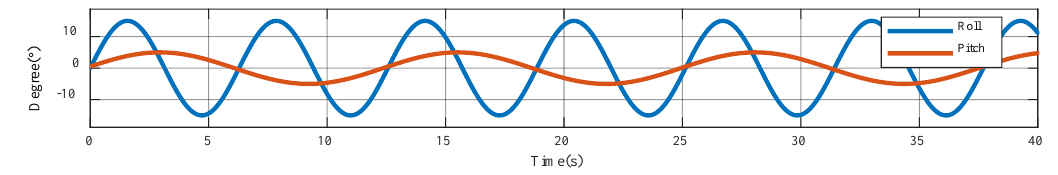
Figure 24. Roll movement and pitch movement of vessel.